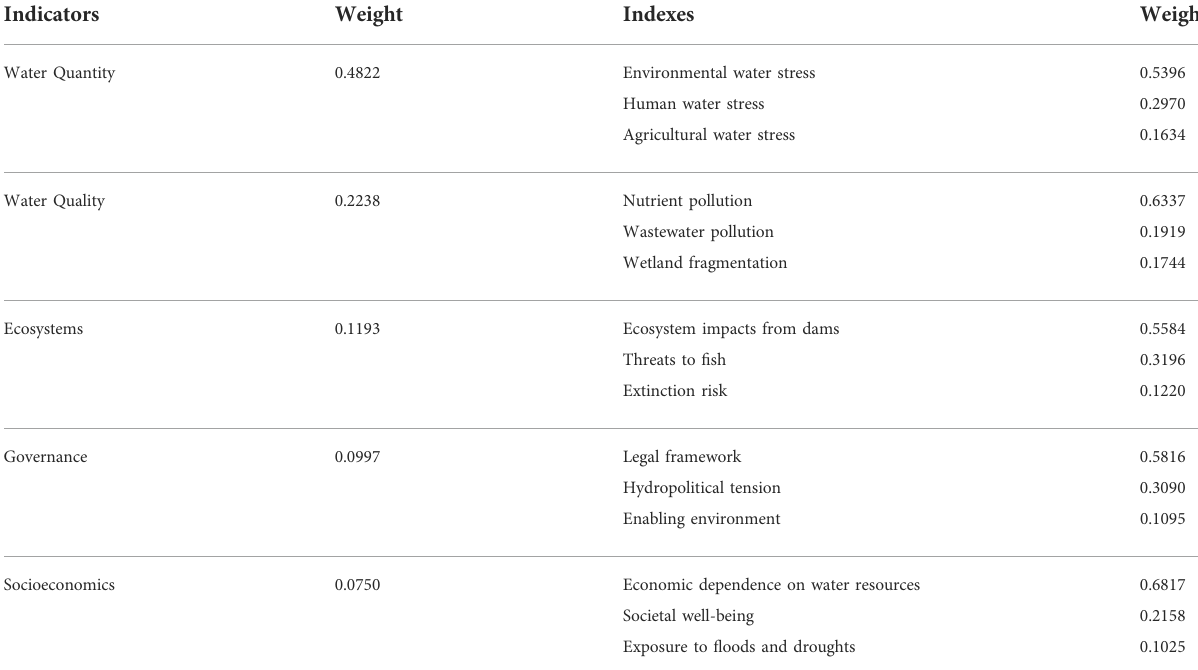
TABLE 5 Weights used in the water risk